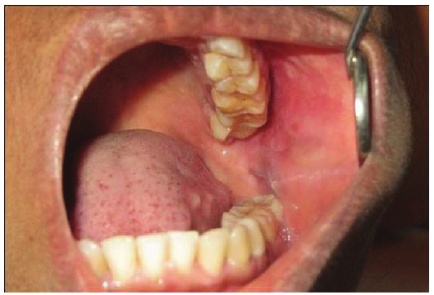
Figure 3: Intraoral appearance.